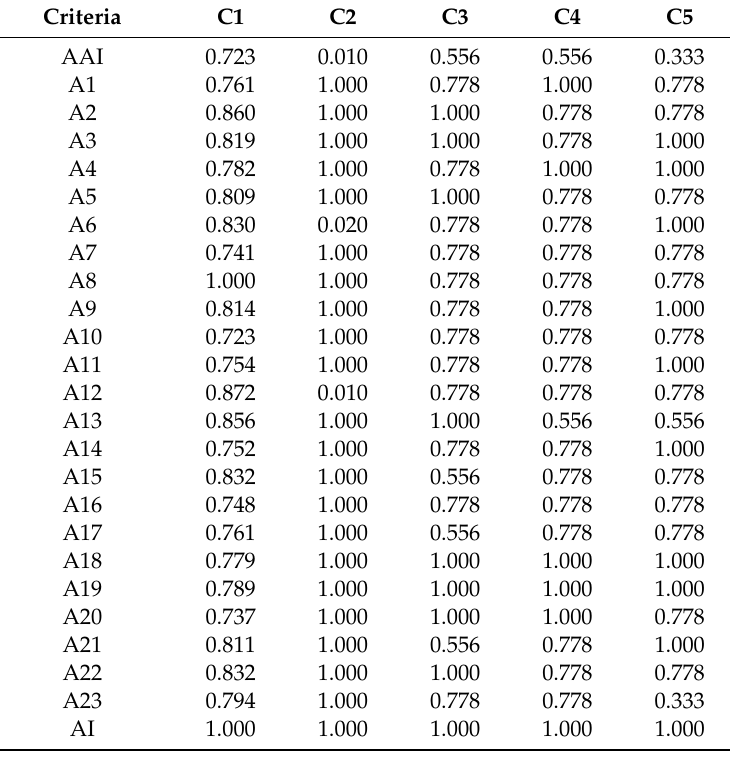
Table 3. Normalized decision